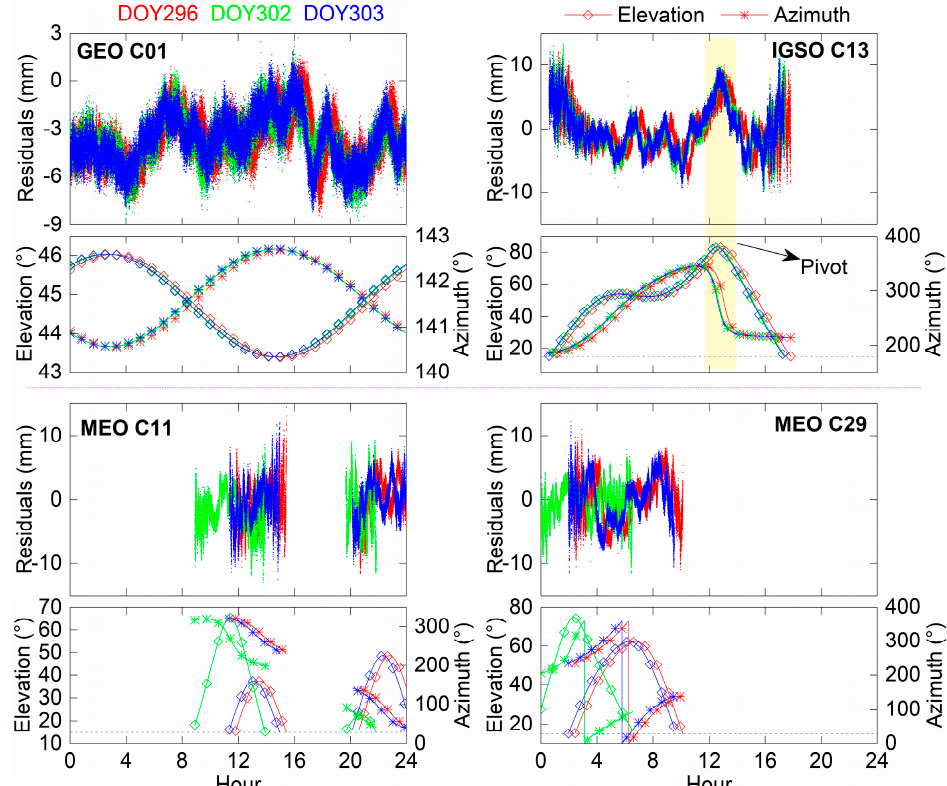
Figure 5. DOY 296/302/303 single-difference residuals series of C01/C11/C13/C29 and the elevation and azimuth angles.